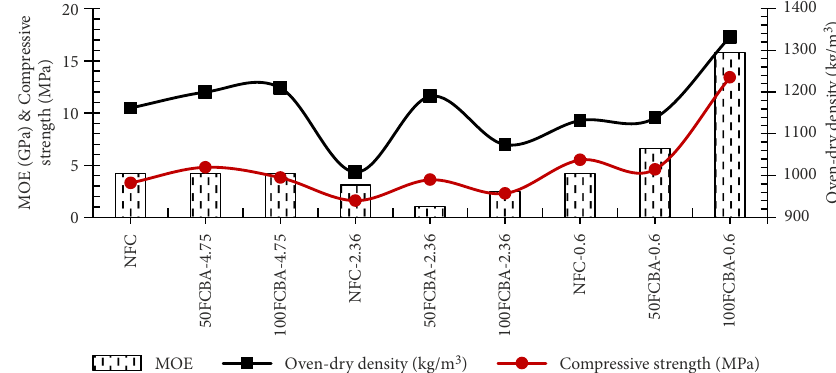
Figure 7. Relationship between modulus of elasticity and compressive strength of LFC with CBA replacement ratio and